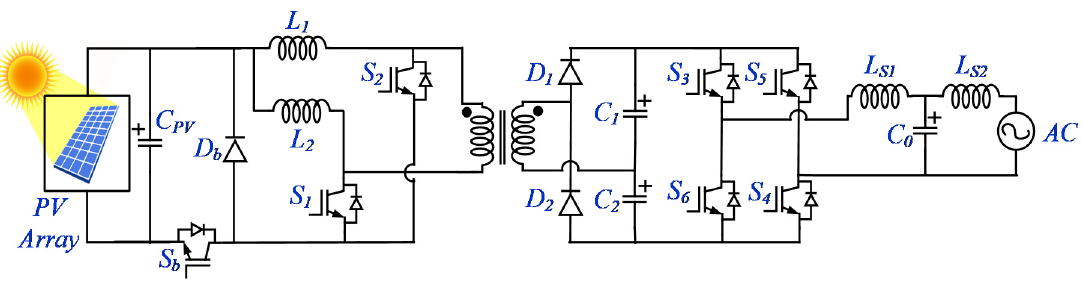
Figure 32. Dual boost converter with full bridge inverter.